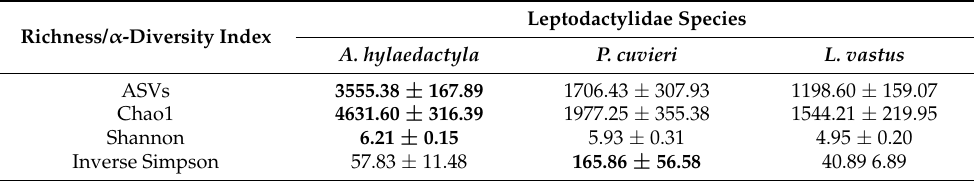
Table 2. Richness and alpha diversity of amplicon sequence variants (ASVs) in the foam nests of A. hylaedactyla , P. cuvieri , and L. vastus .